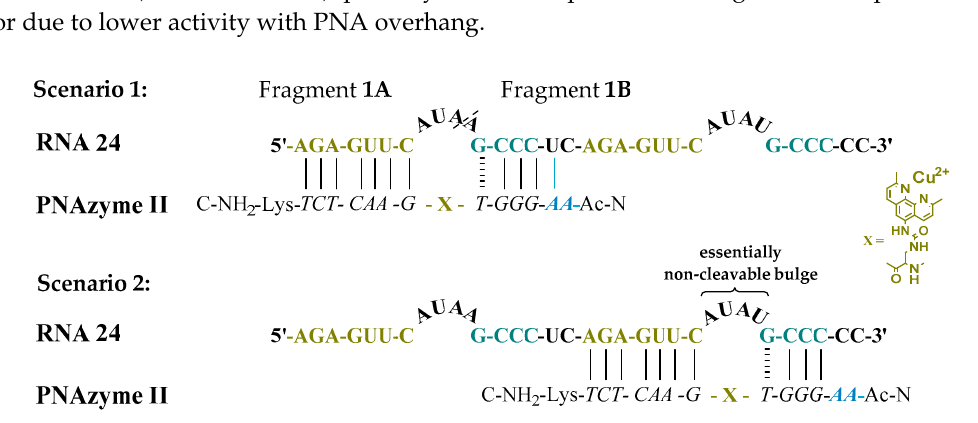
Figure 2. Possible complexes between RNA 24 and PNAzyme II. The dashed line denotes the cleavage site. cleavage